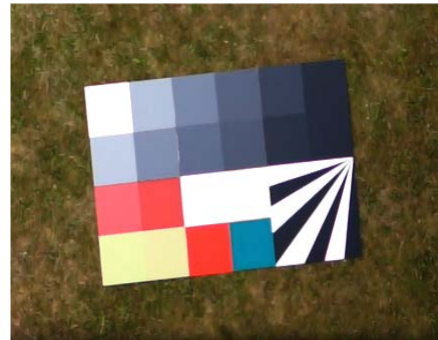
Figure 4a. Part of the RGB PIQuAT image aquired from RGB